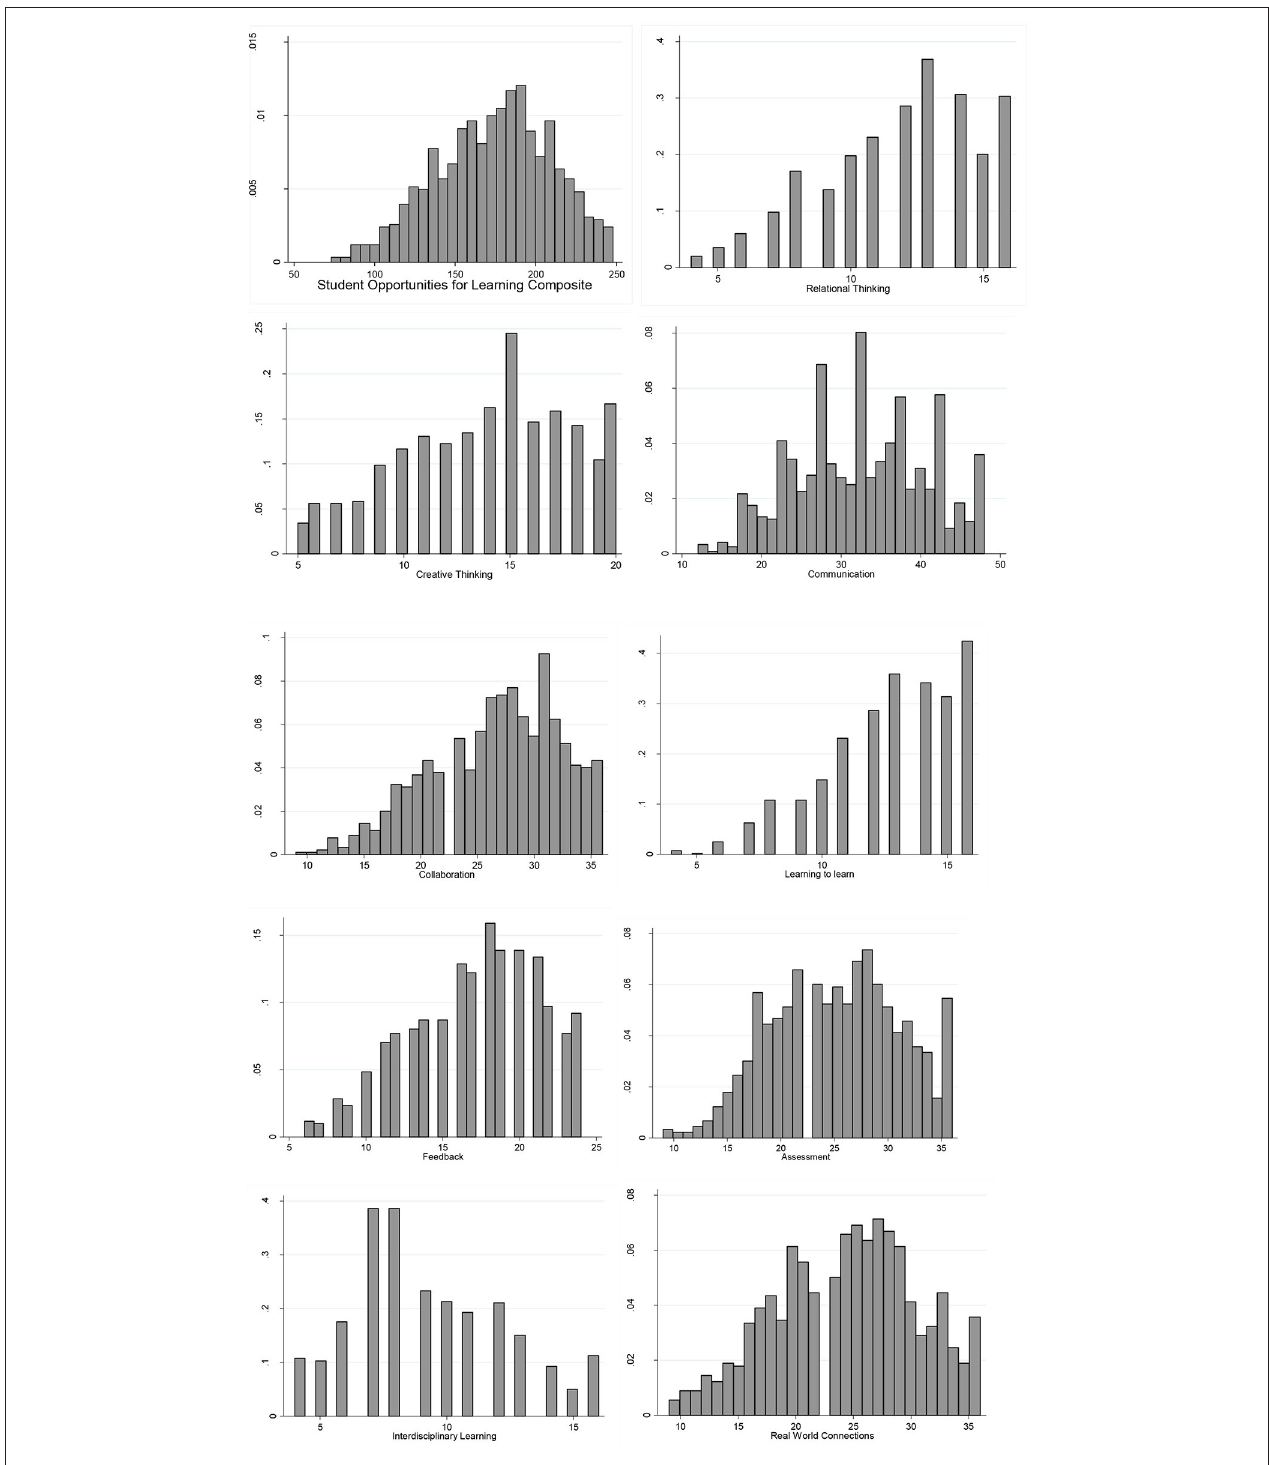
FIGURE 1 | Frequency distribution of raw total scores as well as the nine scales of the measure.